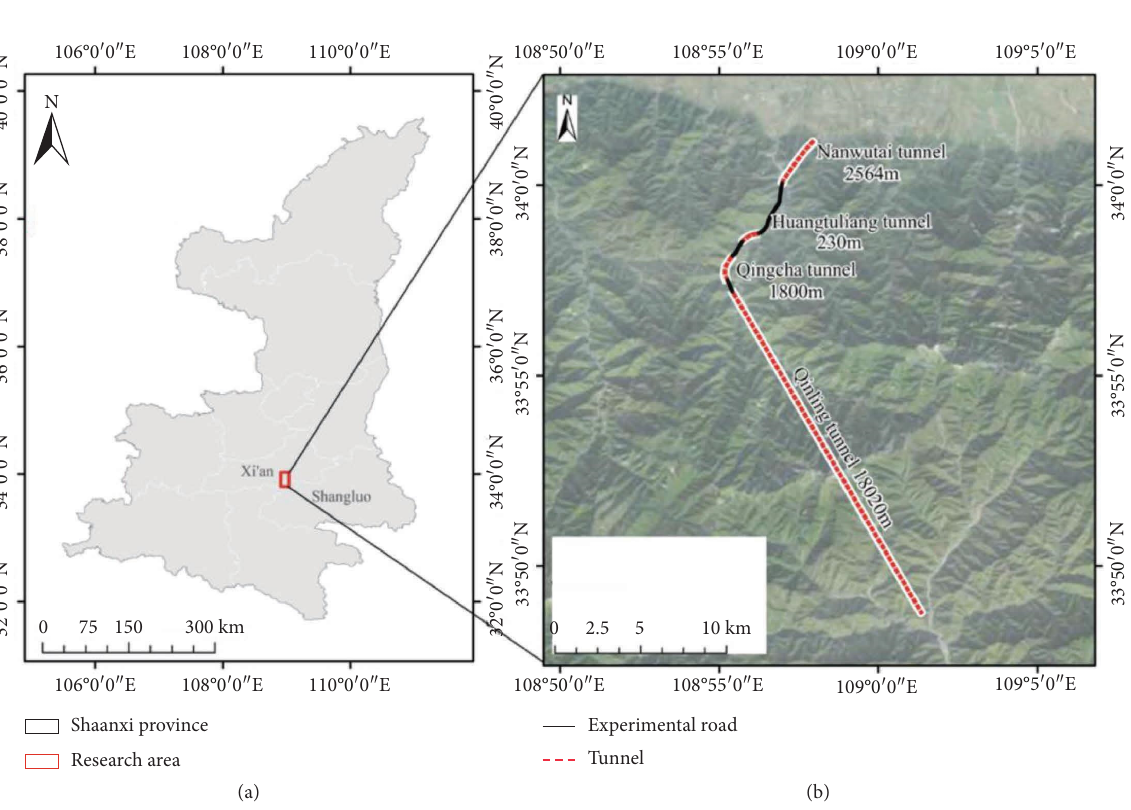
Figure 1: (a) Shaanxi province. (b) Location of the tunnels.